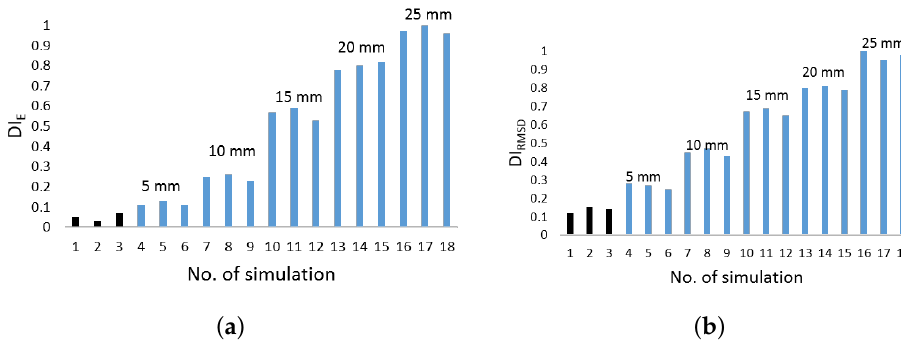
Figure 6. Damage index versus defect size using energy based feature ( a ) and root mean sqare deviation analysis ( b ) carried out at 50